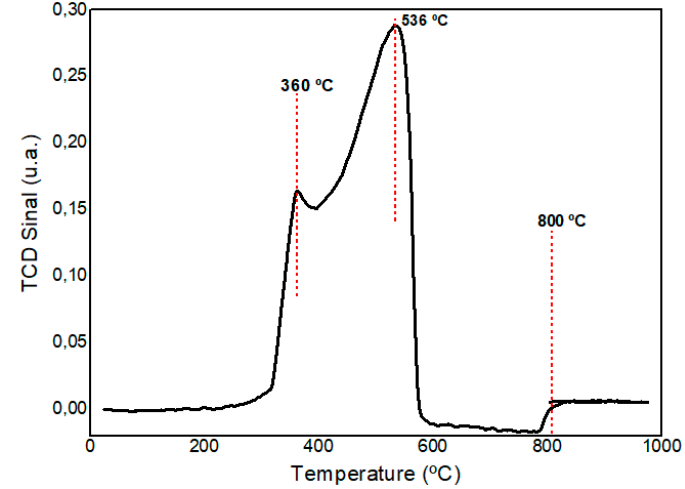
Figure 2. H 2 -TPR profile of fresh NiFe 2 O 4 catalyst.